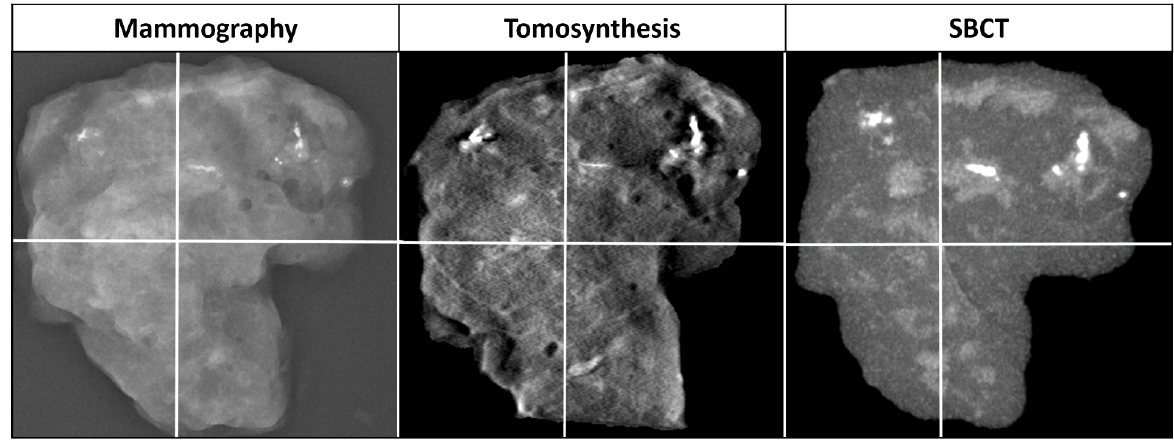
Figure 2. Division of a specimen into four quadrants in mammography, digital breast tomosynthesis, and spiral breast-CT (SBCT). Both readers evaluated specimens per quadrant. In this case, SBCT with a Recon1 reconstruction set and maximum intensity projection (slice thickness 4 mm) is displayed to visualize microcalcifications of different depths in one image. Depiction of details is clearer with thinner slice thicknesses.